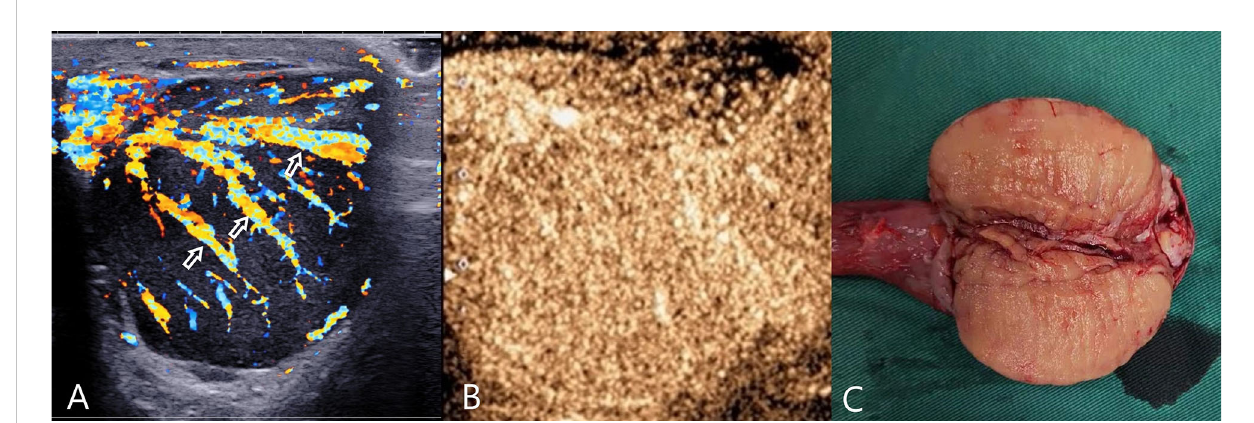
FIGURE 2 Testicular lymphoma. (A) CDFI: hypoechoic mass in the left testis, abundant blood fl ow, with multiple perforating vessels(arrow); (B) CEUS, CEUS showed uniform and high enhancement, and no obvious necrotic area was found. (C) Macro-section, Mass occupying the entire testicle; CDFI, Color Doppler Flow Imaging; CEUS, contrast-enhanced ultrasonography.